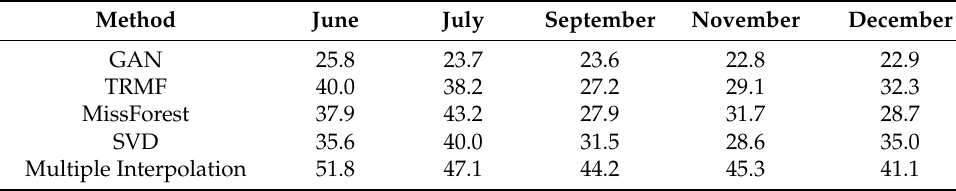
Table 3. The comparison of the RMSE values of several